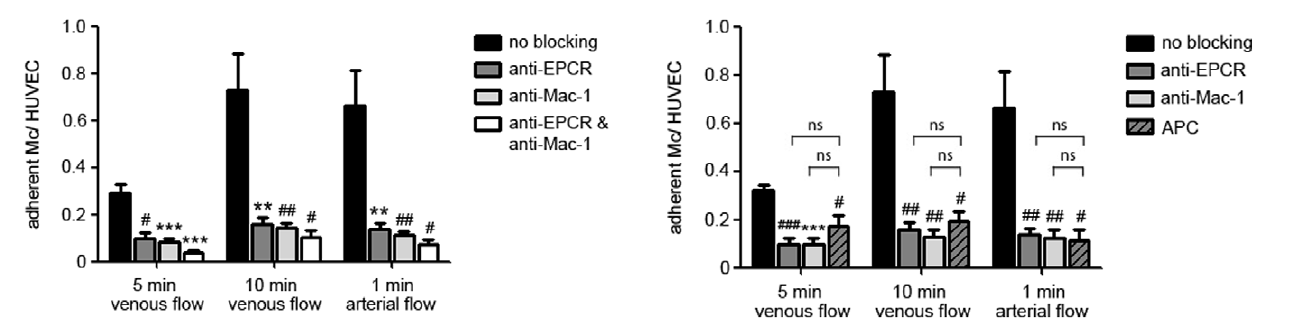
Figure 6. Equal blocking of monocyte binding to endothelial cells by anti-EPCR and APC under flow conditions. Monocyte binding to HUVECs in dynamic adhesion assay after 5 min (left) and 10 min venous flow (middle), and after 1 min arterial flow (right). Pre- treatment of HUVECs with anti-EPCR (dark grey bars), anti-Mac-1 (light grey bars), or with activated protein C (drotrecogin alfa; crosshatched bars) diminished monocyte adhesion to an equal extent compared to control. (*** p , 0.0001; ### p , 0.0005; ## p , 0.005; # p , 0.05 vs. no blocking; ns = statistically not